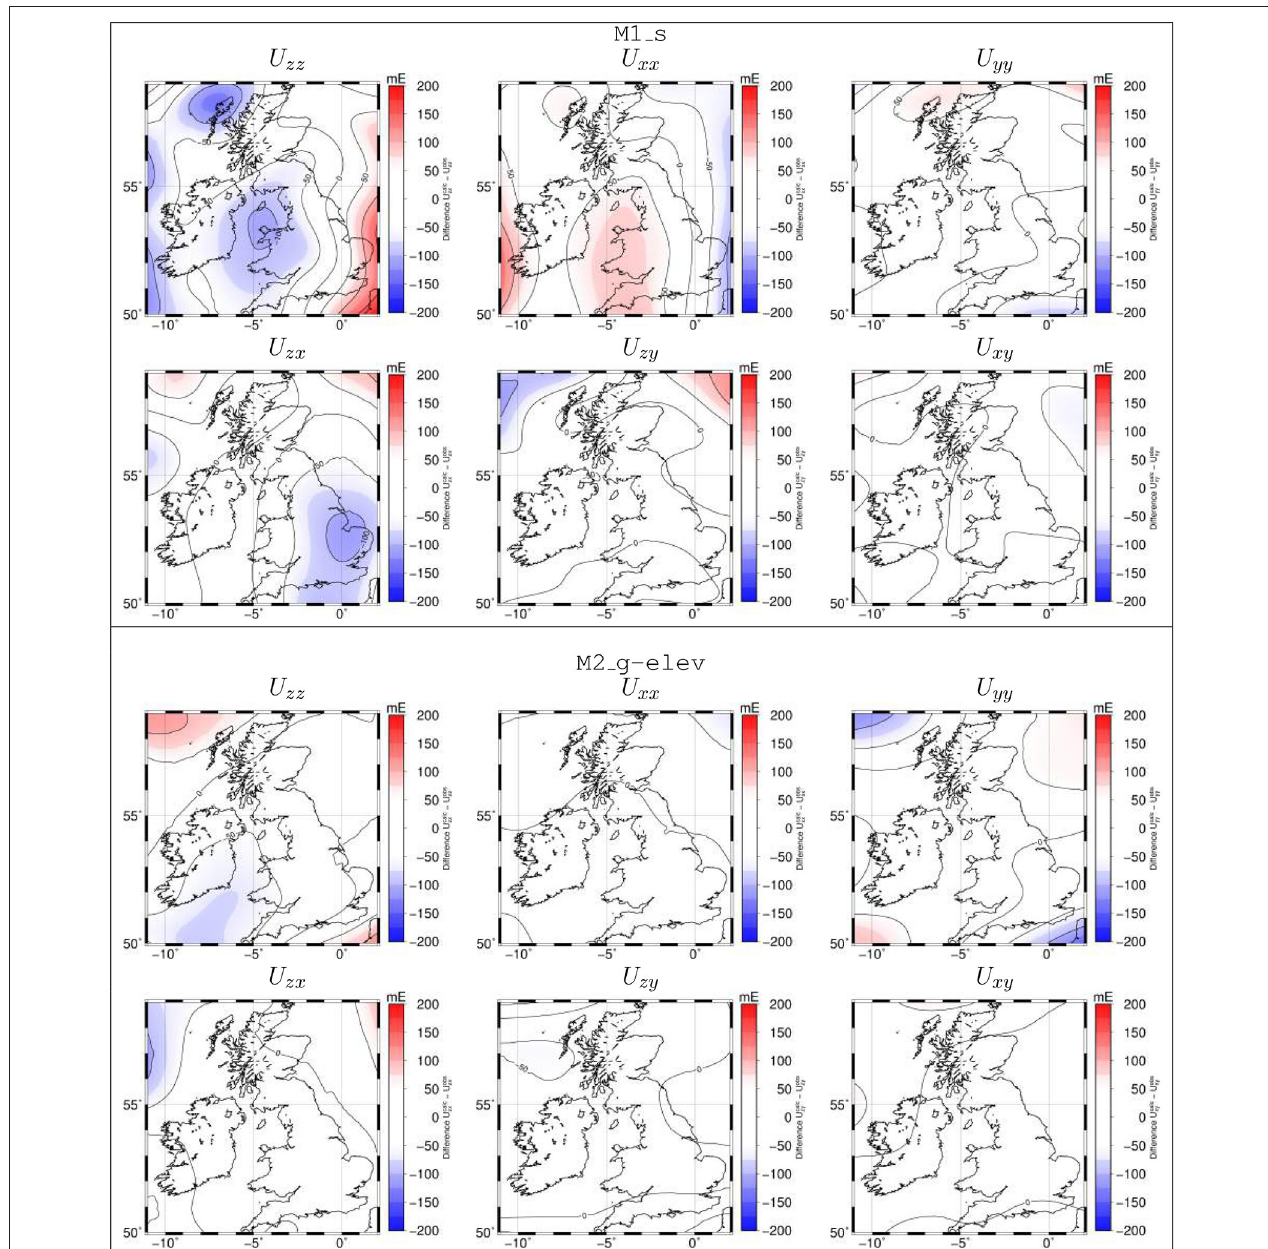
FIGURE 7 | Difference between calculated and observed ( Figure 2 ) gravity gradient tensor components at satellite level. Top panel corresponds to the model M1_s and bottom panel corresponds to model M2_g-elev .